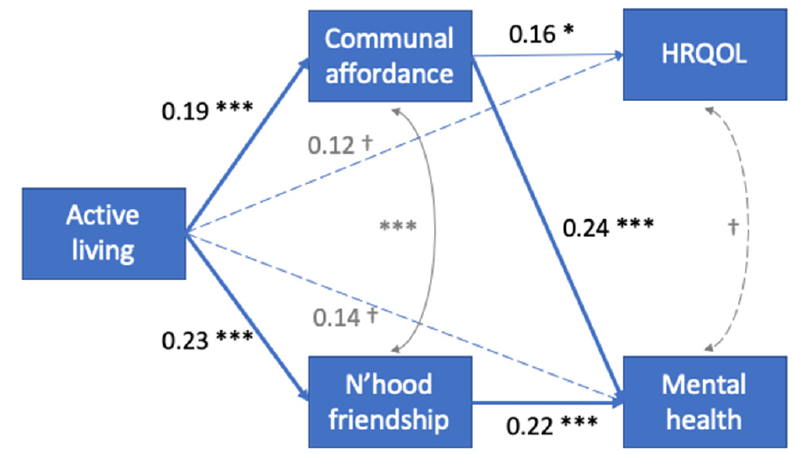
Figure 2. Mediation analysis through neighborhood cohesion. Path coefficients are shown (n = 270; *** p < 0.001; ** p < 0.01; * p < 0.05; † p < 0.10). Combining findings from both models, communal affordance and neighborhood friendship each explained 0.05/0.24 = 21% of the effects on mental health. Communal affordance explained 0.03/0.07 = 43% of the effects on HRQOL. A third model was constructed to further examine the relationship between commu- nal affordance and neighborhood friendship and factors of mental health. Communal affordance was associated with emotional support (B = 0.32), and together they mediated the relationship between environment pleasantness (B = 0.36) and autonomy (B = 0.25), yielding indirect effects of B indirect = 0.03 (16%). Neighborhood friendship was associated with interpersonal skills (B = 0.37), and together they mediated the relationship from environment pleasantness (B = 0.28) and time outdoors (B = 0.33) to autonomy (B = 0.29) and coping (B = 0.39), yielding indirect effects of B indirect = 0.03 + 0.04 + 0.04 + 0.05 = 0.16 (84%). No other paths were found (See Figure 3).